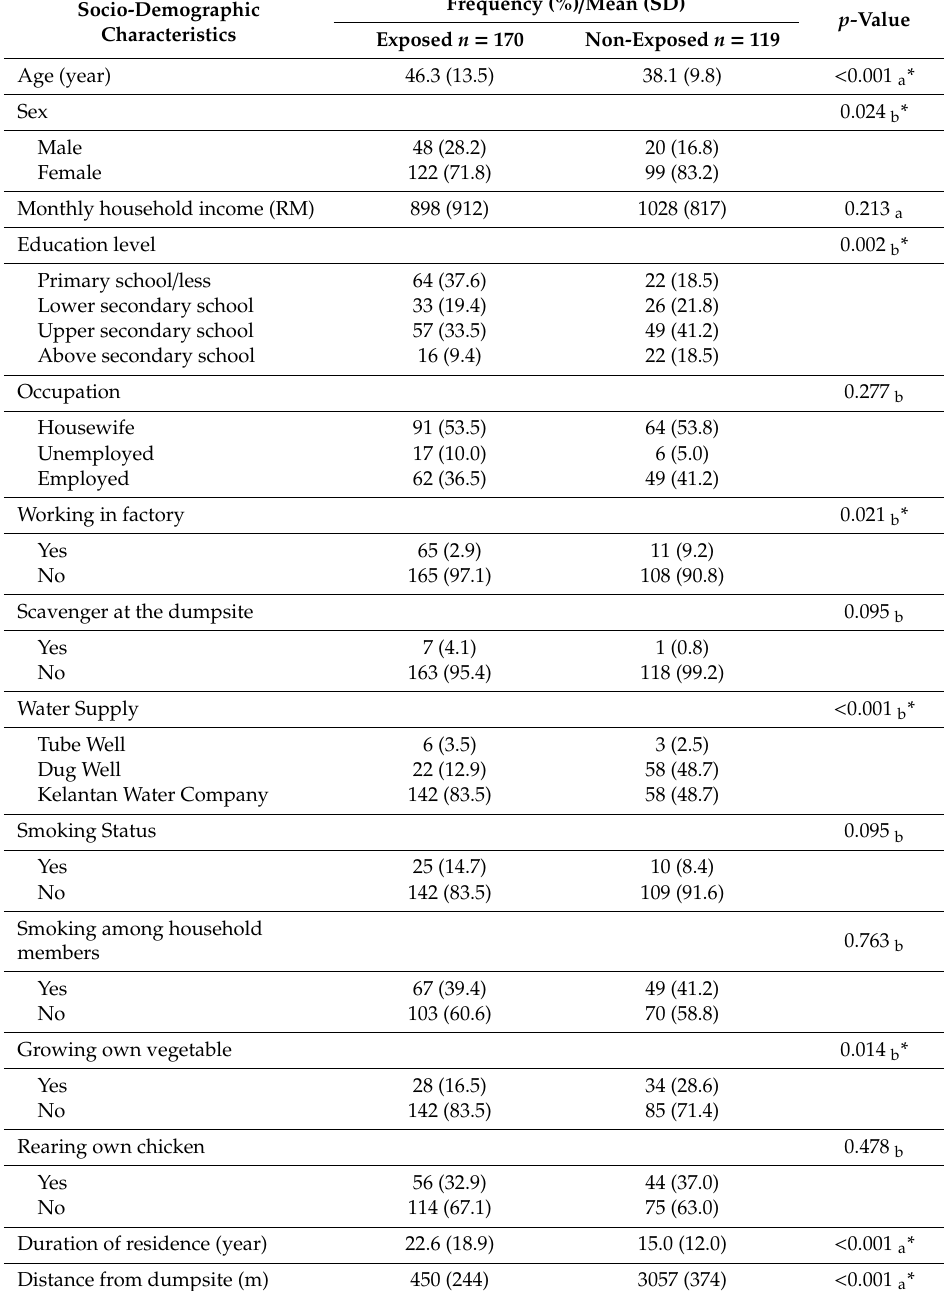
Table 1. Socio-demographic comparison between residents in the exposed and non-exposed groups to the solid waste dumpsite in